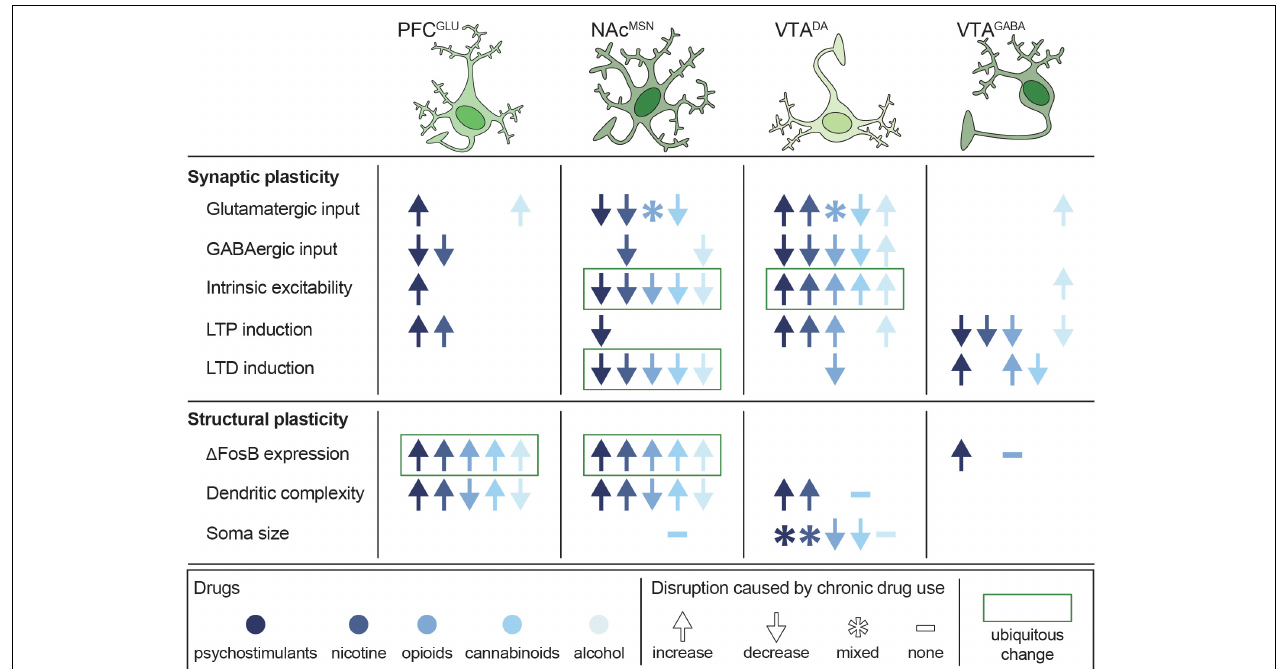
FIGURE 5 | Persistent disruptions in synaptic and structural plasticity caused by long-term use of potentially addictive drugs. Studies are organized by cell type (columns) and type of disruption (rows), with symbols depicting the net change in plasticity and color depicting which drug was tested. Data from Bonci and Williams (1996), Kang et al. (1996, 1998), Robinson and Kolb (1997), Robinson and Kolb (2004), Badiani et al. (1999), Mansvelder and McGehee (2000), Dahchour and De Witte (2000), Uslaner et al. (2001), Brown and Kolb (2001), Robinson et al. (2002), Saal et al. (2003), Amantea et al. (2004), Hamilton and Kolb (2005), Nasif et al. (2005), Kolb et al. (2006), Kolb et al. (2018), Huang et al. (2007), Zhou et al. (2007), Van Den Oever et al. (2008), Kalivas et al. (2009), Niehaus et al. (2010), Russo et al. (2010), Bowers et al. (2010), Spiga et al. (2010), Levine et al. (2011), Dacher and Nugent (2011), Kroener et al. (2012), Lobo et al. (2013), Trifilieff and Martinez (2013), Mello et al. (2014), Peterson et al. (2015), Bloomfield et al. (2016), Creed et al. (2016), Ehlinger et al. (2016), Hearing et al. (2016), Morud et al. (2016), Friend L. et al., 2017), Langlois and Nugent (2017), Edwards et al. (2017), Spencer et al. (2018), You et al. (2018), Hwang and Lupica (2019), Kruse et al. (2019), McDevitt et al. (2019), Neuhofer et al. (2019), Pickel et al. (2019), and Ponzoni et al.